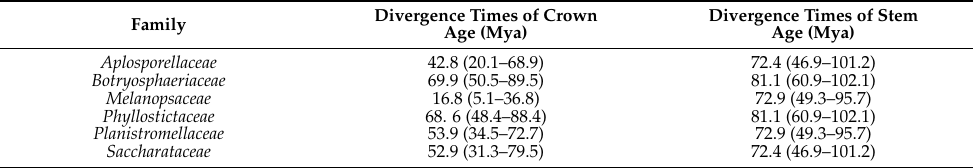
Table 3. Divergence times of crown age and stem age of families of Botryosphaeriales . Family